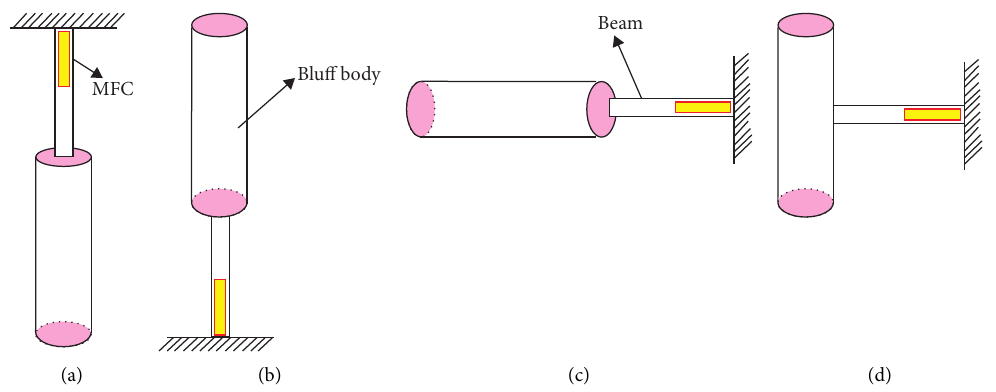
Figure 4: Different orientations. (a) Bottom. (b) Top. (c) Horizontal. (d) Vertical [53].